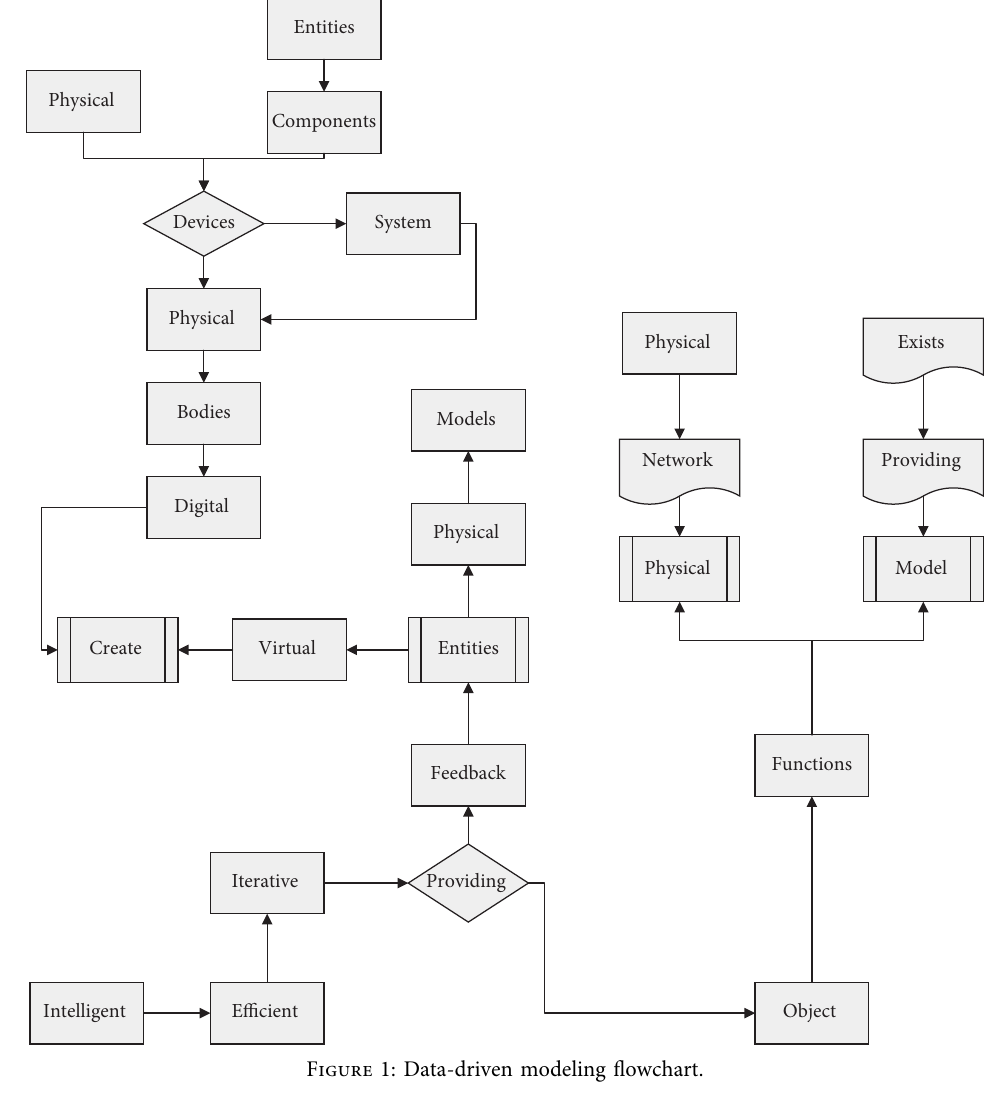
Figure 1: Data-driven modeling